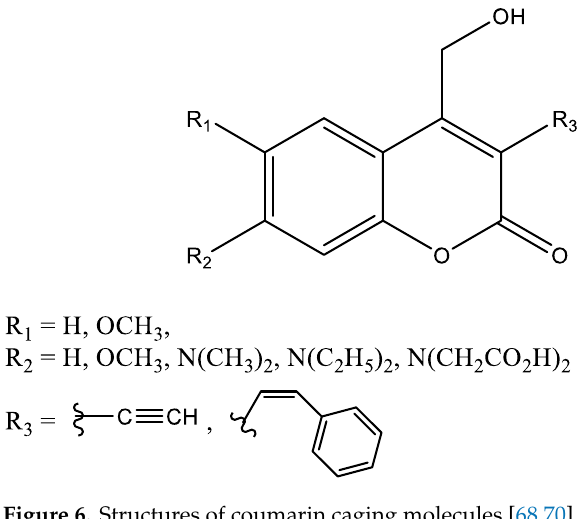
Figure 6. Structures of coumarin caging molecules [68,70].